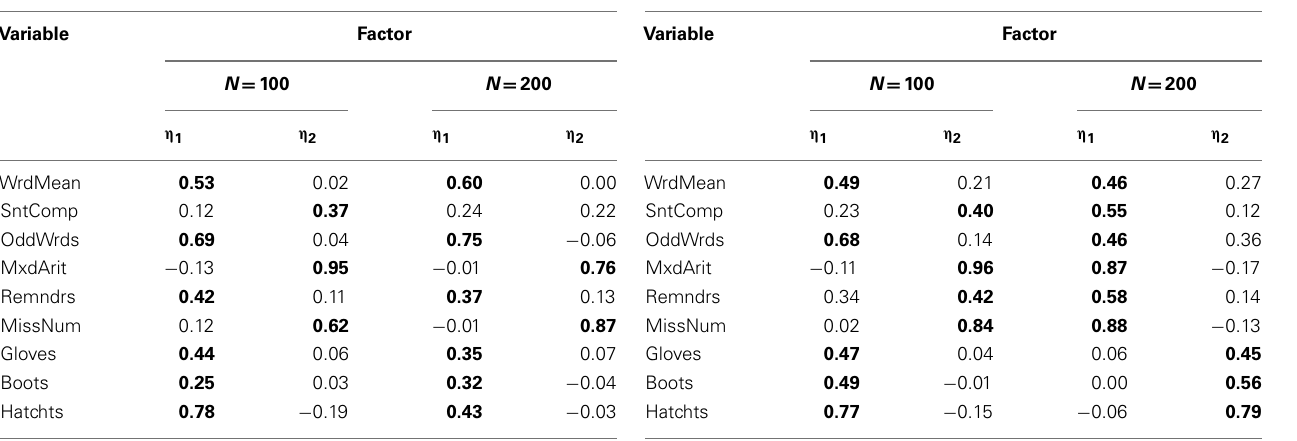
Table 11 |Two-factor model loading matrix obtained with EFA of product-moment R among Case 3 item-level variables.